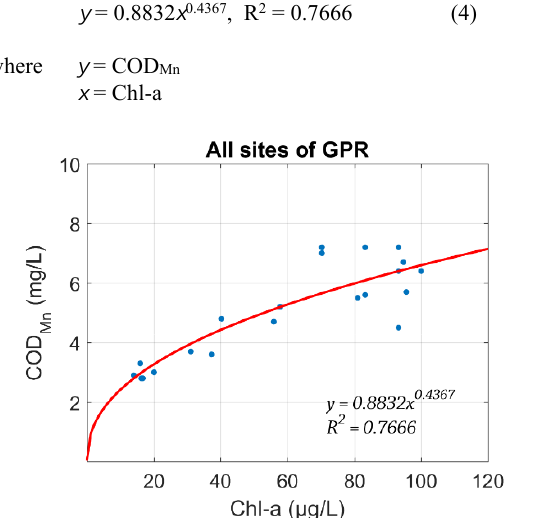
Figure 6. The fitting curve of COD Mn and Chl-a in back-channel of GPR